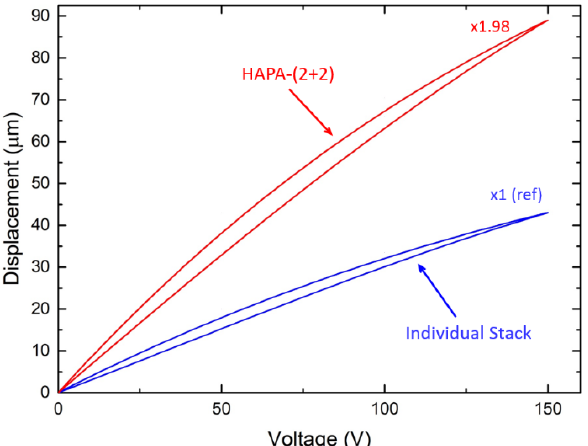
Figure 6. Unipolar displacement responses for both NEC-Tokin piezoceramic stack (Model AE0505D44H40DF) and the HAPA-(2 + 2) actuator fabricated from the same under no added load condition. The maximum applied voltage used was 150 V.